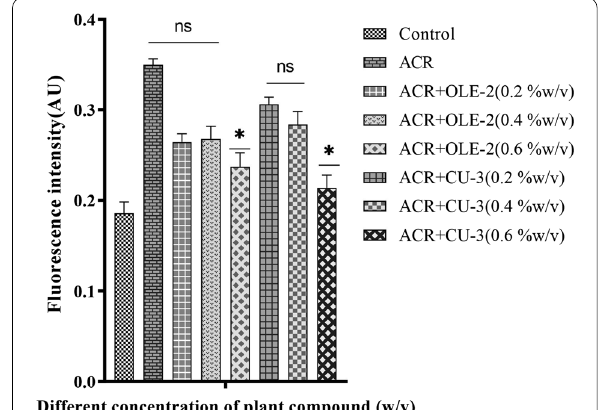
Fig. 4 Climbing assays can be used to examine the locomotor Fig. 6 ROS levels in control and treated groups of male D. activity of co-exposed of ACR plant fraction flies compared with melanogaster. Plant fraction supplementation decreases the level + control and treated groups. Plant fraction showed (OLE-2 and of ROS in plant fraction treated flies’ group in comparison to control. CU-3) improvement in the climbing ability. Significance analysed Statistical significance was analysed by one-way ANOVA. Error bar by one-way ANOVA. Error bar represents the Mean SD. The p represents the Mean SD. The p value * p < 0.05 were considered as ± values * p < 0.05 and ** p < 0.01 were considered as significant while ± significant while comparing ACR treated group and co-exposed to comparing ACR treated group and co-exposed to ACR plant ACR plant fraction group + fraction +